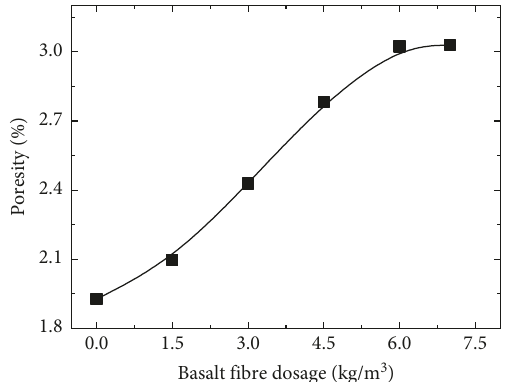
Figure 11: Porosity versus basalt fibre dosage.